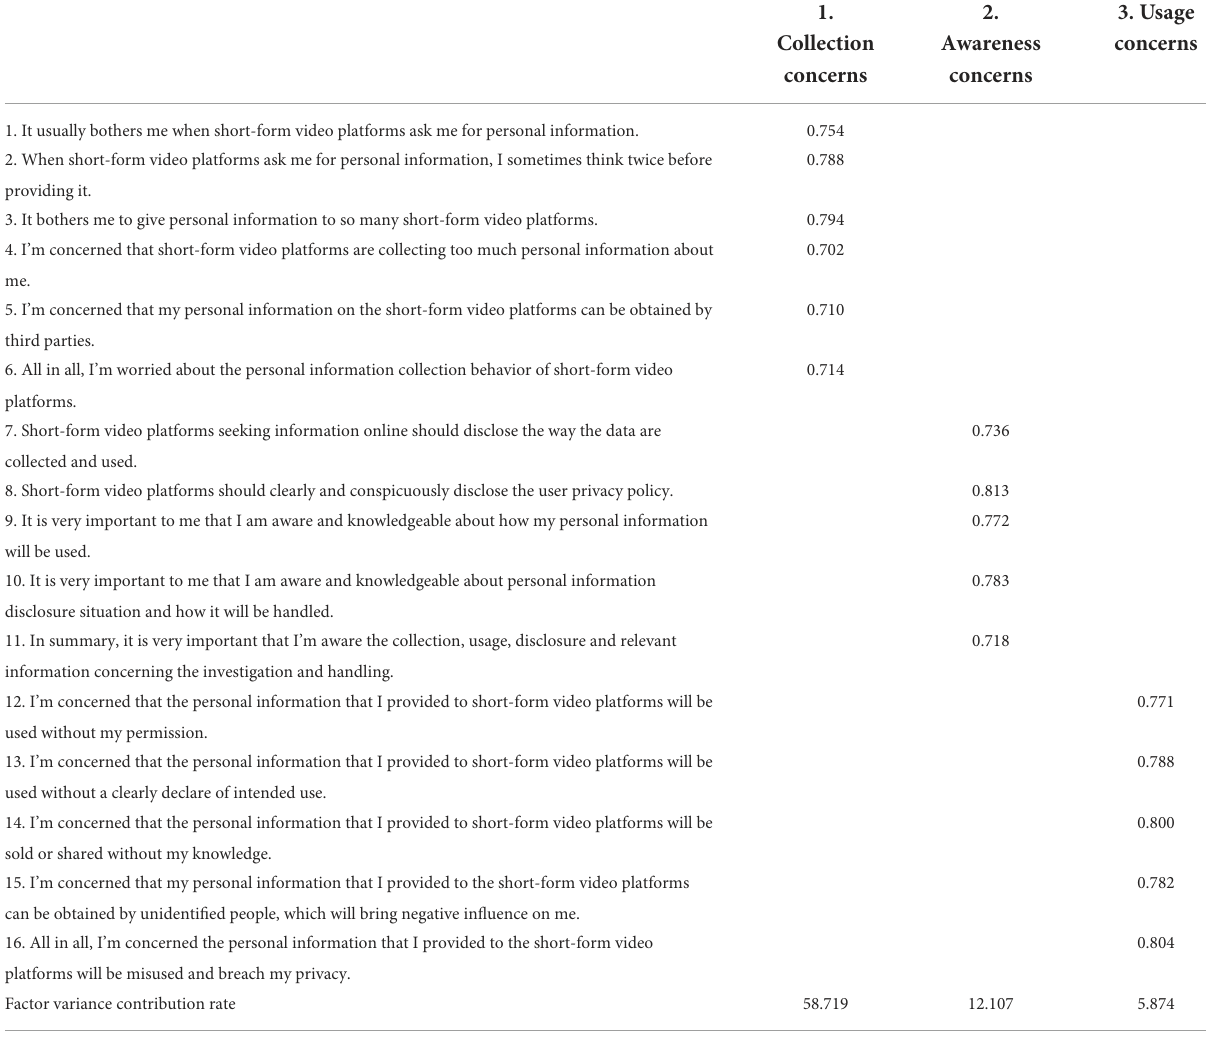
TABLE 7 Exploratory factor analysis ( n =